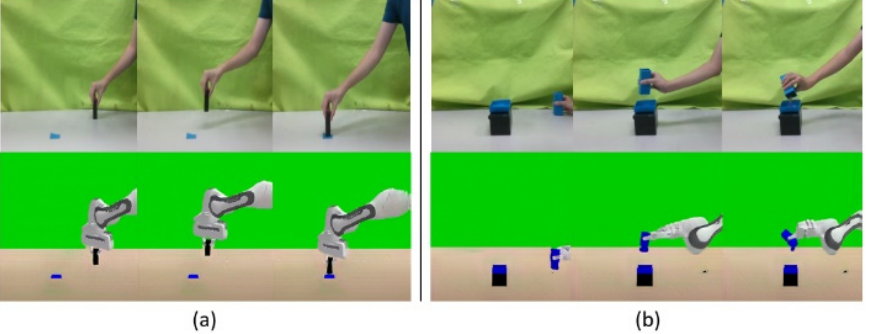
Figure 7. Demonstration image and CycleGAN result. ( a ) Relatively vertical human hand data. ( b ) Relatively horizontal human hand data.